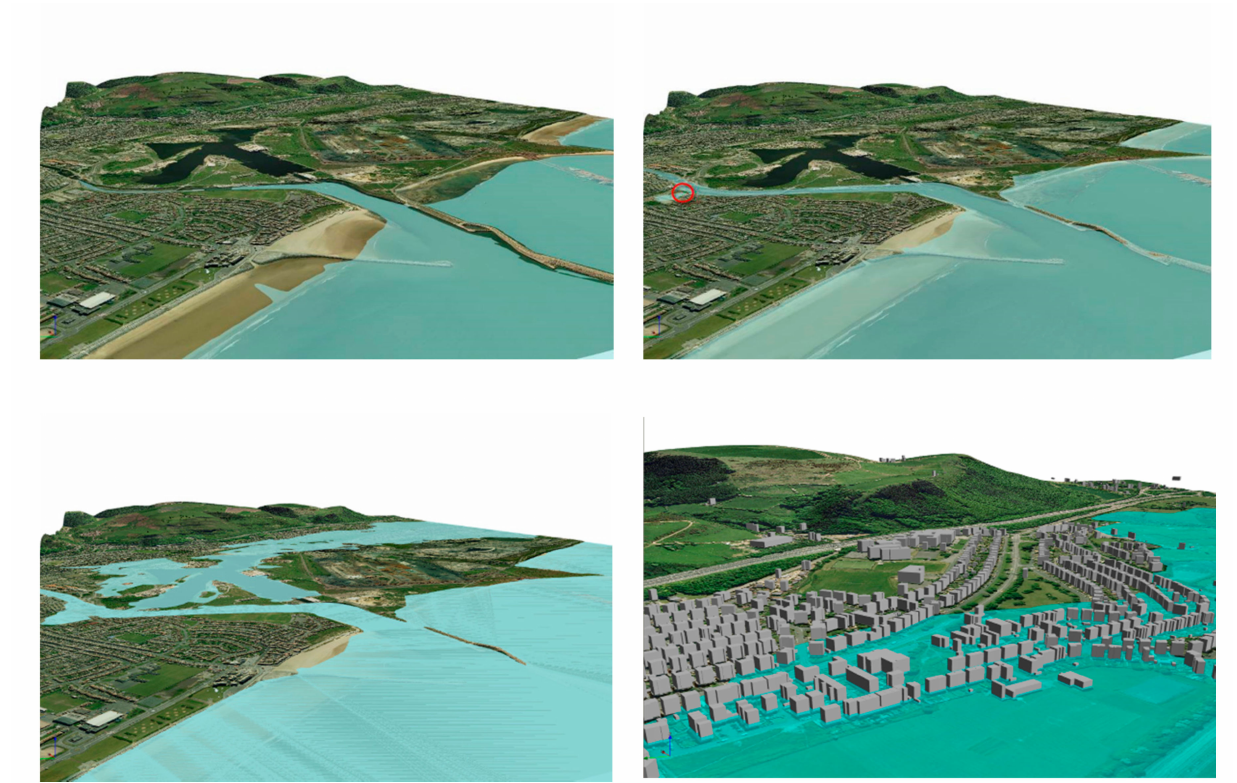
Figure 4. Modeling of local flood risk (Encom MapInfo Discover)—3D model according to flood dynamics.